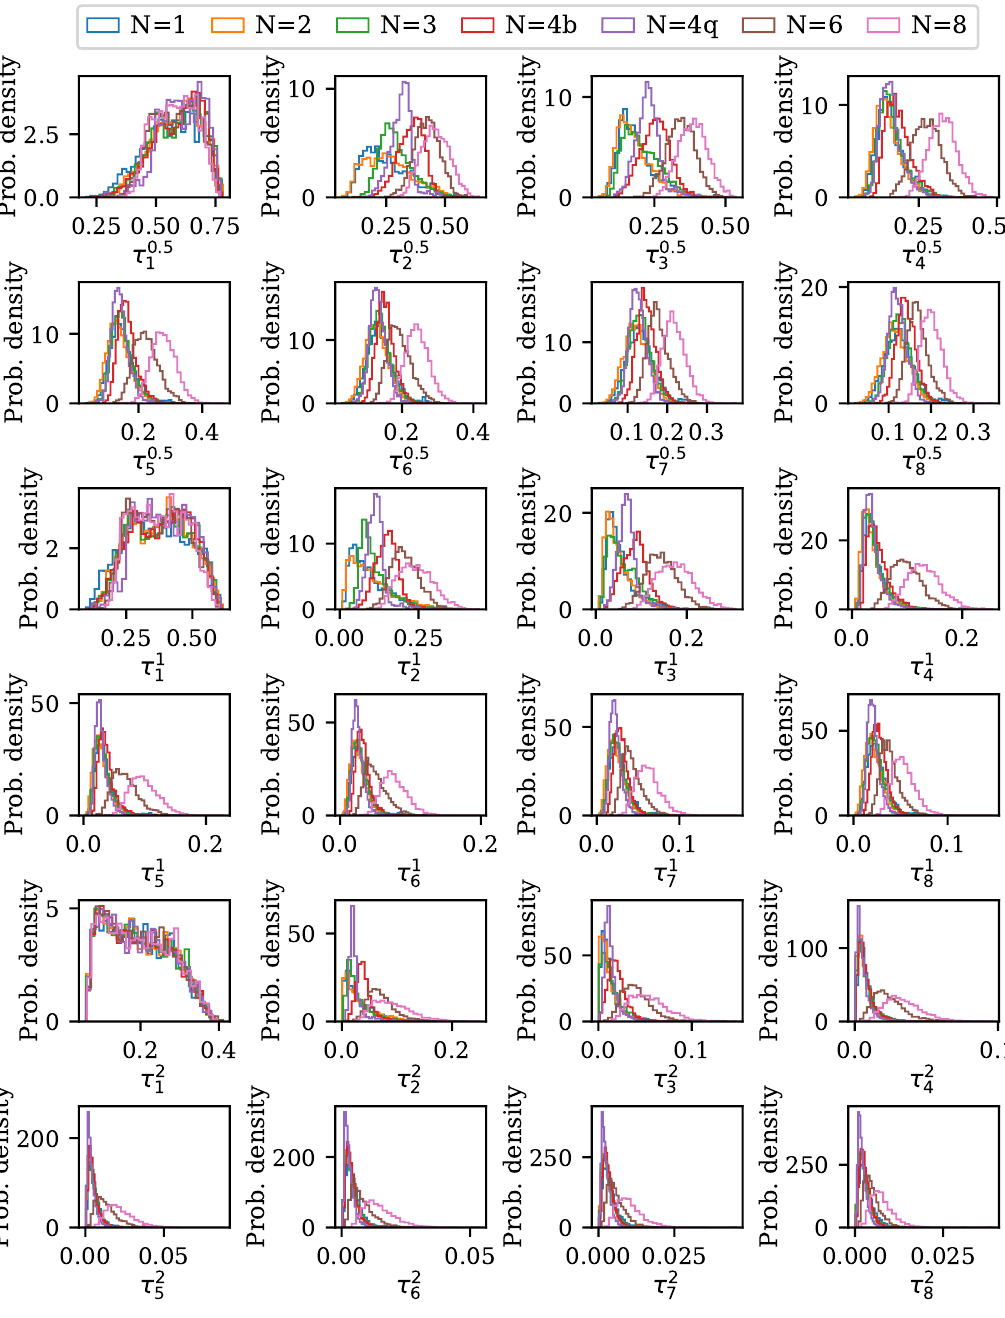
Figure 3 . Distributions of N-subjettiness [35] variables τ β samples of simulated jets with various N hard